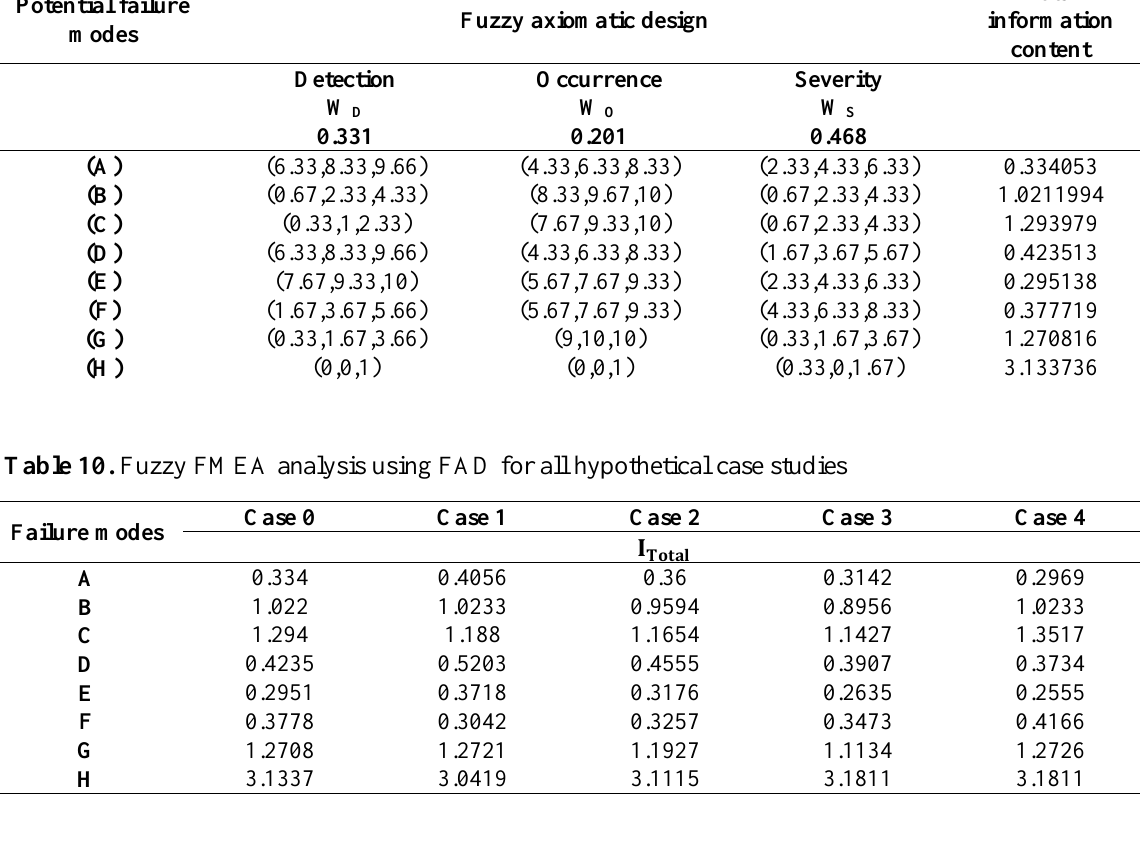
Table 9. Fuzzy FMEA analysis using FAD Potential failure